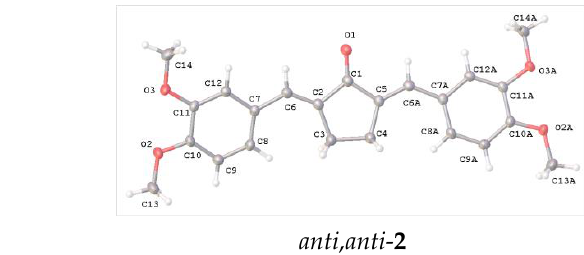
Figure 4. Structure and atom numbering of molecules syn , syn - 2 and anti , anti - 2 .